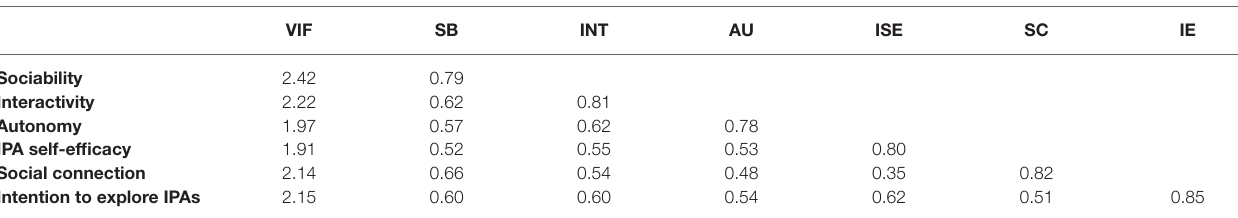
TABLE 2 | Discriminant